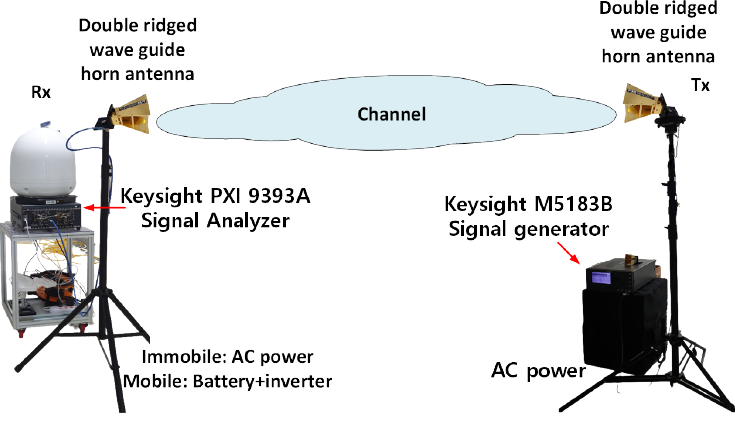
Figure 1. Channel sounder